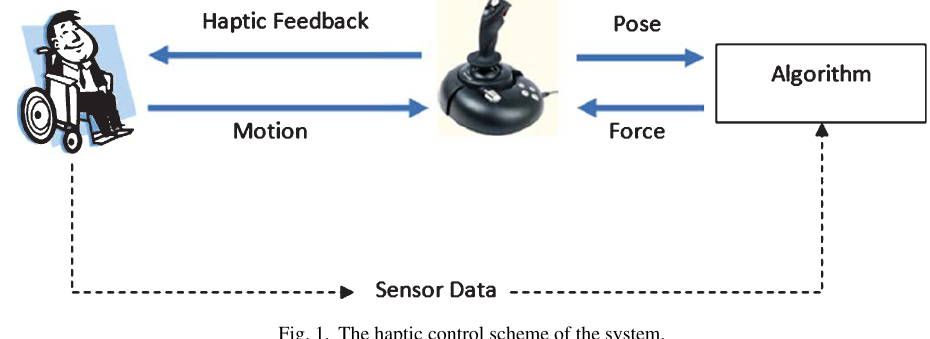
Fig. 1. The haptic control scheme of the